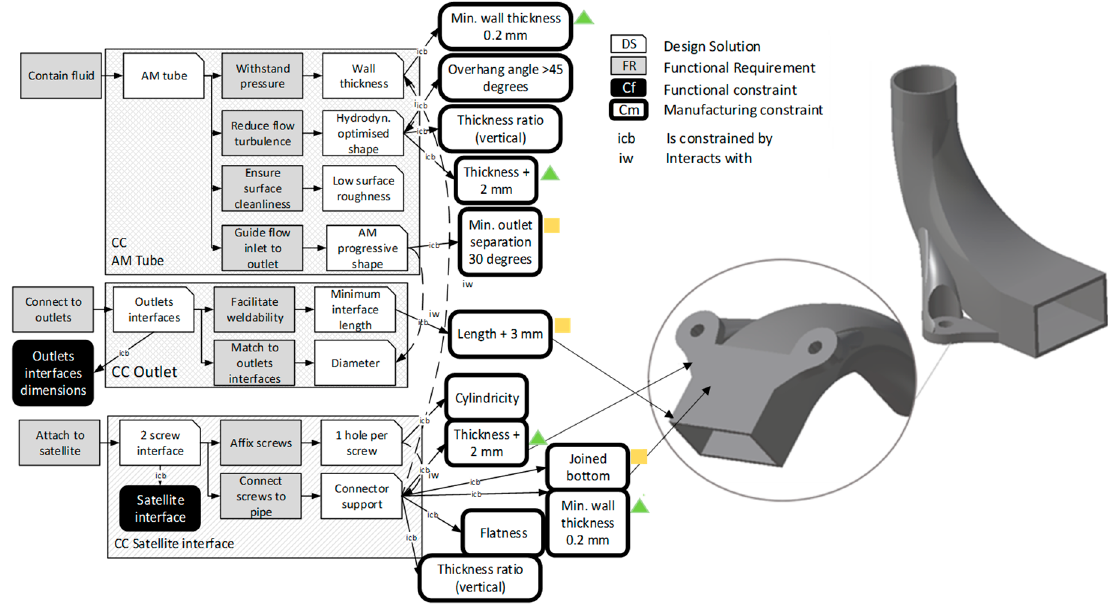
Figure 7. Redesigned FM tree after prototyping activities. The green arrows indicate constraints that have been updated, and the orange squares indicate new constraints.